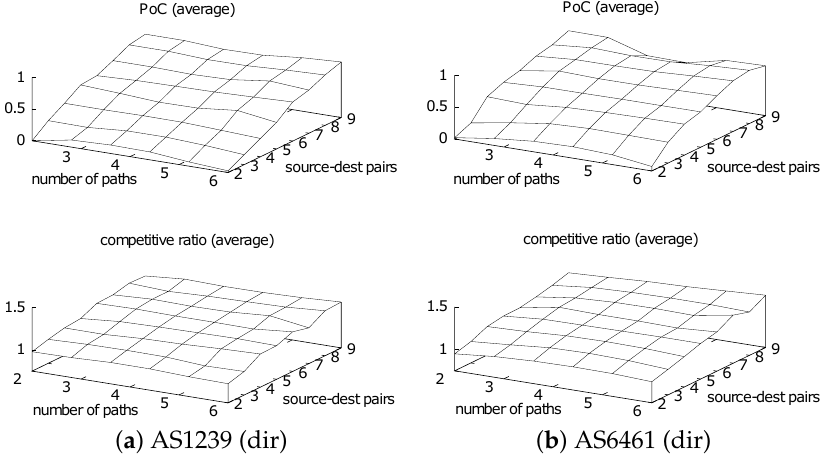
Figure 3. The PoC, the competitive ratio, and the EVoC for the directed version of ( a ) the NSF, ( b ) the AS3257, ( c ) the AS1239, ( d ) the AS6461, the ( e ) AS3967 and ( f ) the AS1755 topology, and undirected version of ( g ) the NSF, ( h ) the AS3257, and ( i ) the AS1755 topology, as the function of the number of users K .